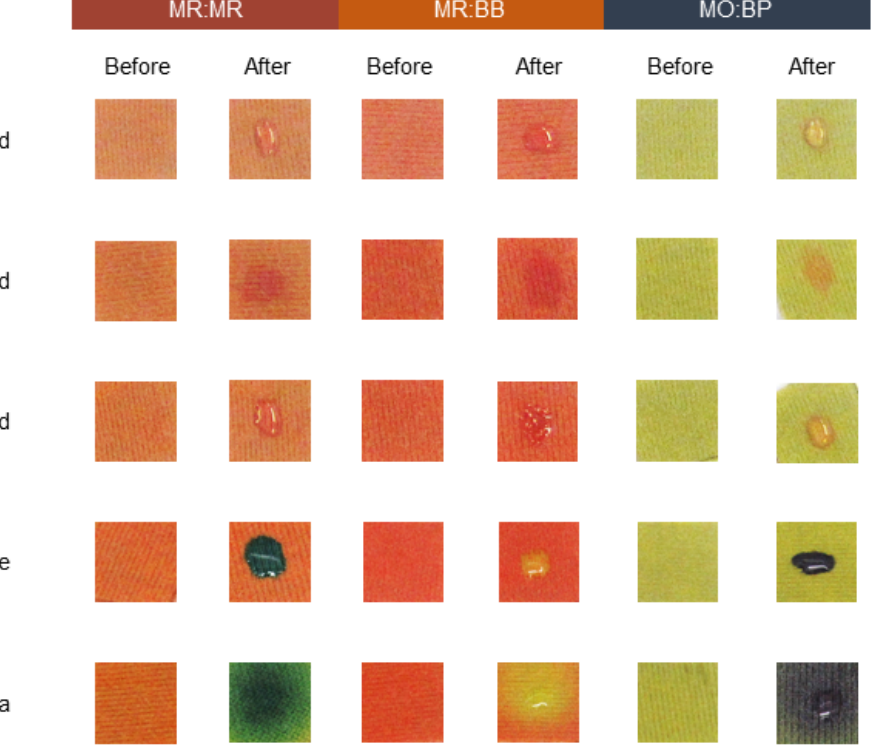
Figure 8. Sensitivity of polyester knits functionalized with different pH sensors, to acidic and basic solutions. The sensors used were: methyl red and bromothymol blue (MR:BB); methyl red and methyl red sodium salt (MR:MR); and methyl orange and bromocresol purple